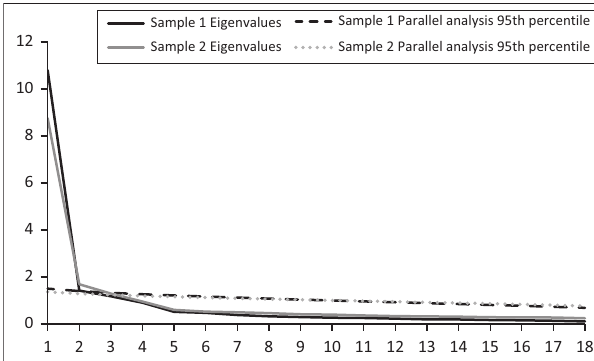
FIGURE 4: Parallel analysis plot.